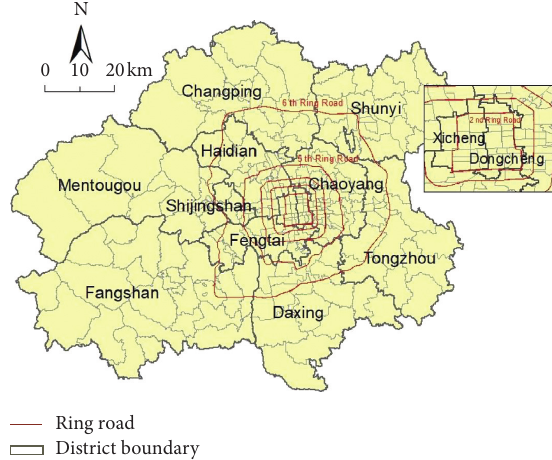
Figure 1: Administrative divisions for the study area